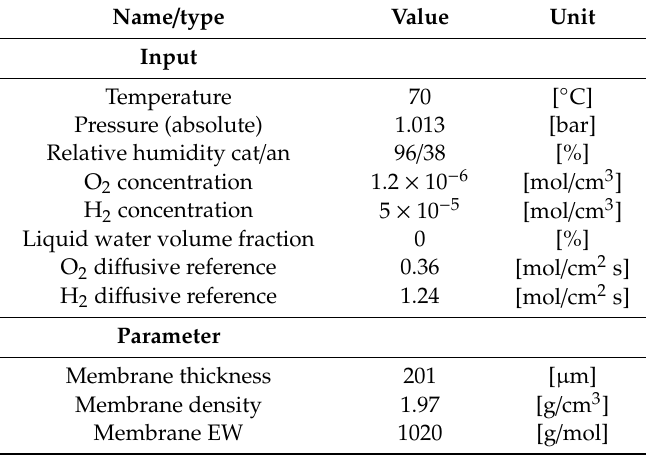
Table 1. Inputs and parameters for the reference